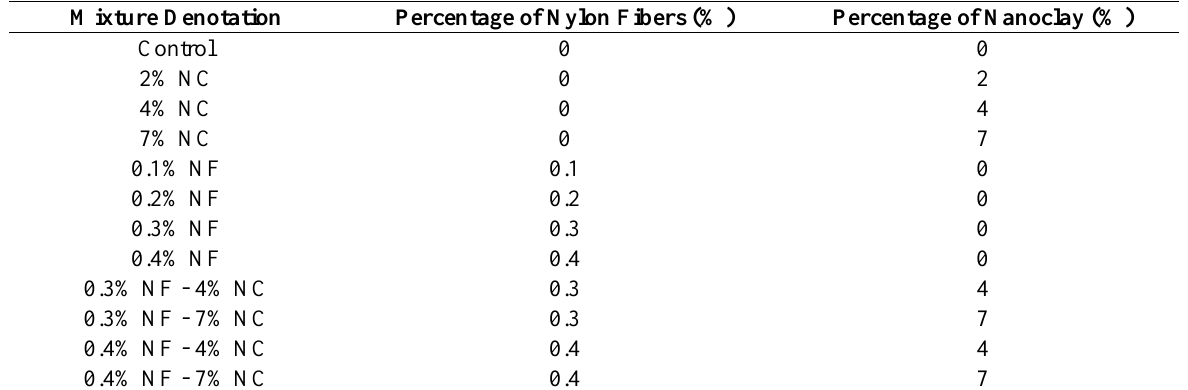
Table 5. Mixtures used in this research